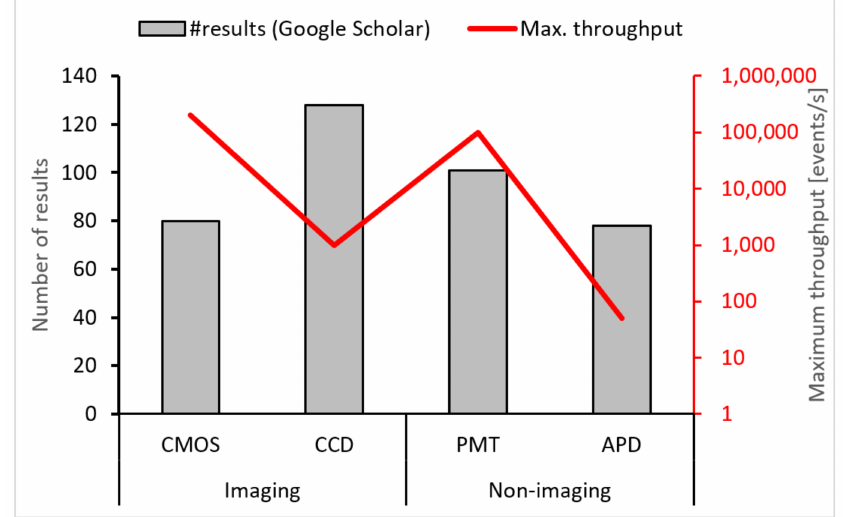
Figure 4. Sensor types and their relevance to droplet microflow cytometry (DMFC). On the vertical axis, there are several results for each sensor type based on a Boolean search from Google Scholar. The red line shows the maximum reported throughput of each sensor